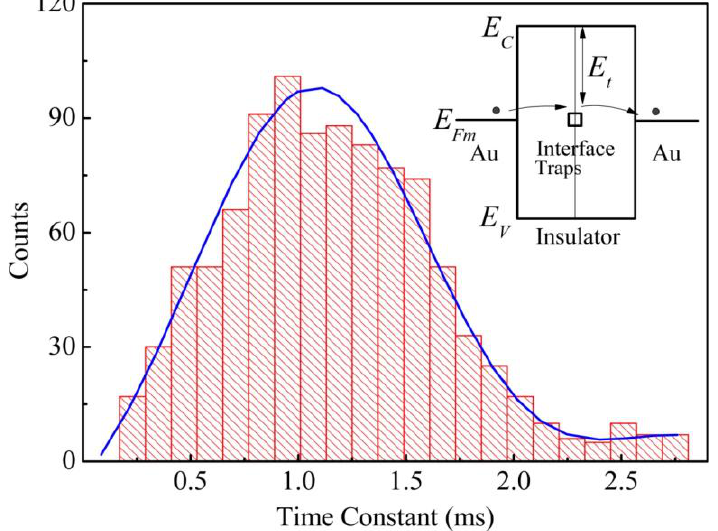
Figure 9. A typical histogram of the time intervals for “off” state for a sample measured at 95 mV. Inset shows the energy band diagram of the Au/Insulator/Au structure. Electrons tunnel though the traps located at the contact interface between the alien